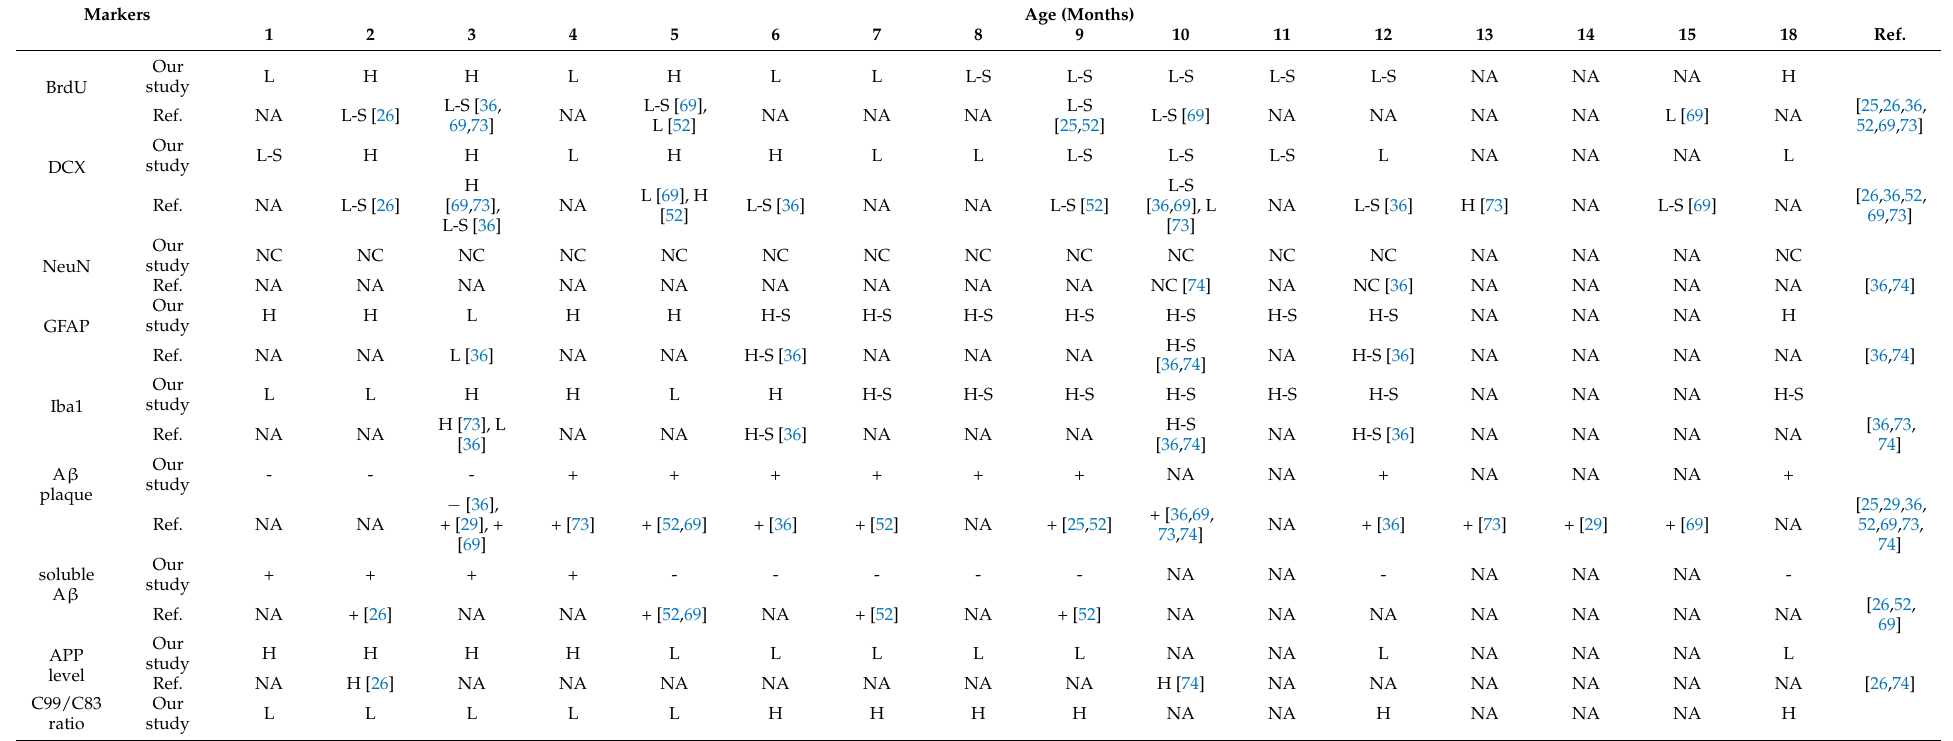
Table 1. Age-related pathological changes in APP/PS1 mice. Comparison table of our findings to literature data. L: lower than WT or low concentration, L-S: significantly lower than WT, H: higher than WT or high concentration H-S: significantly higher than WT, NC: no change in group difference, -: disappearance, +: appearance, NA: data not available, Ref.: